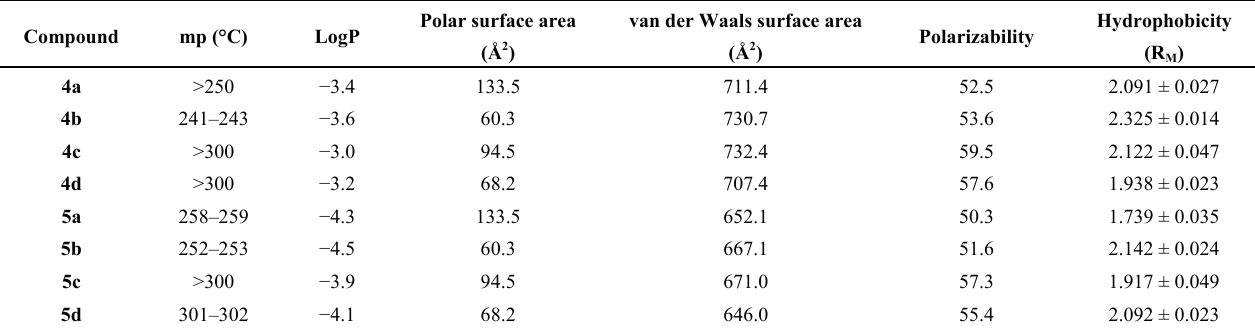
Table 2. Physicochemical properties of synthesized salts. LogP, polar and van der Waals surface areas and polarizability were calculated using MarvingSketch 6.0.2. R presented as the mean ±